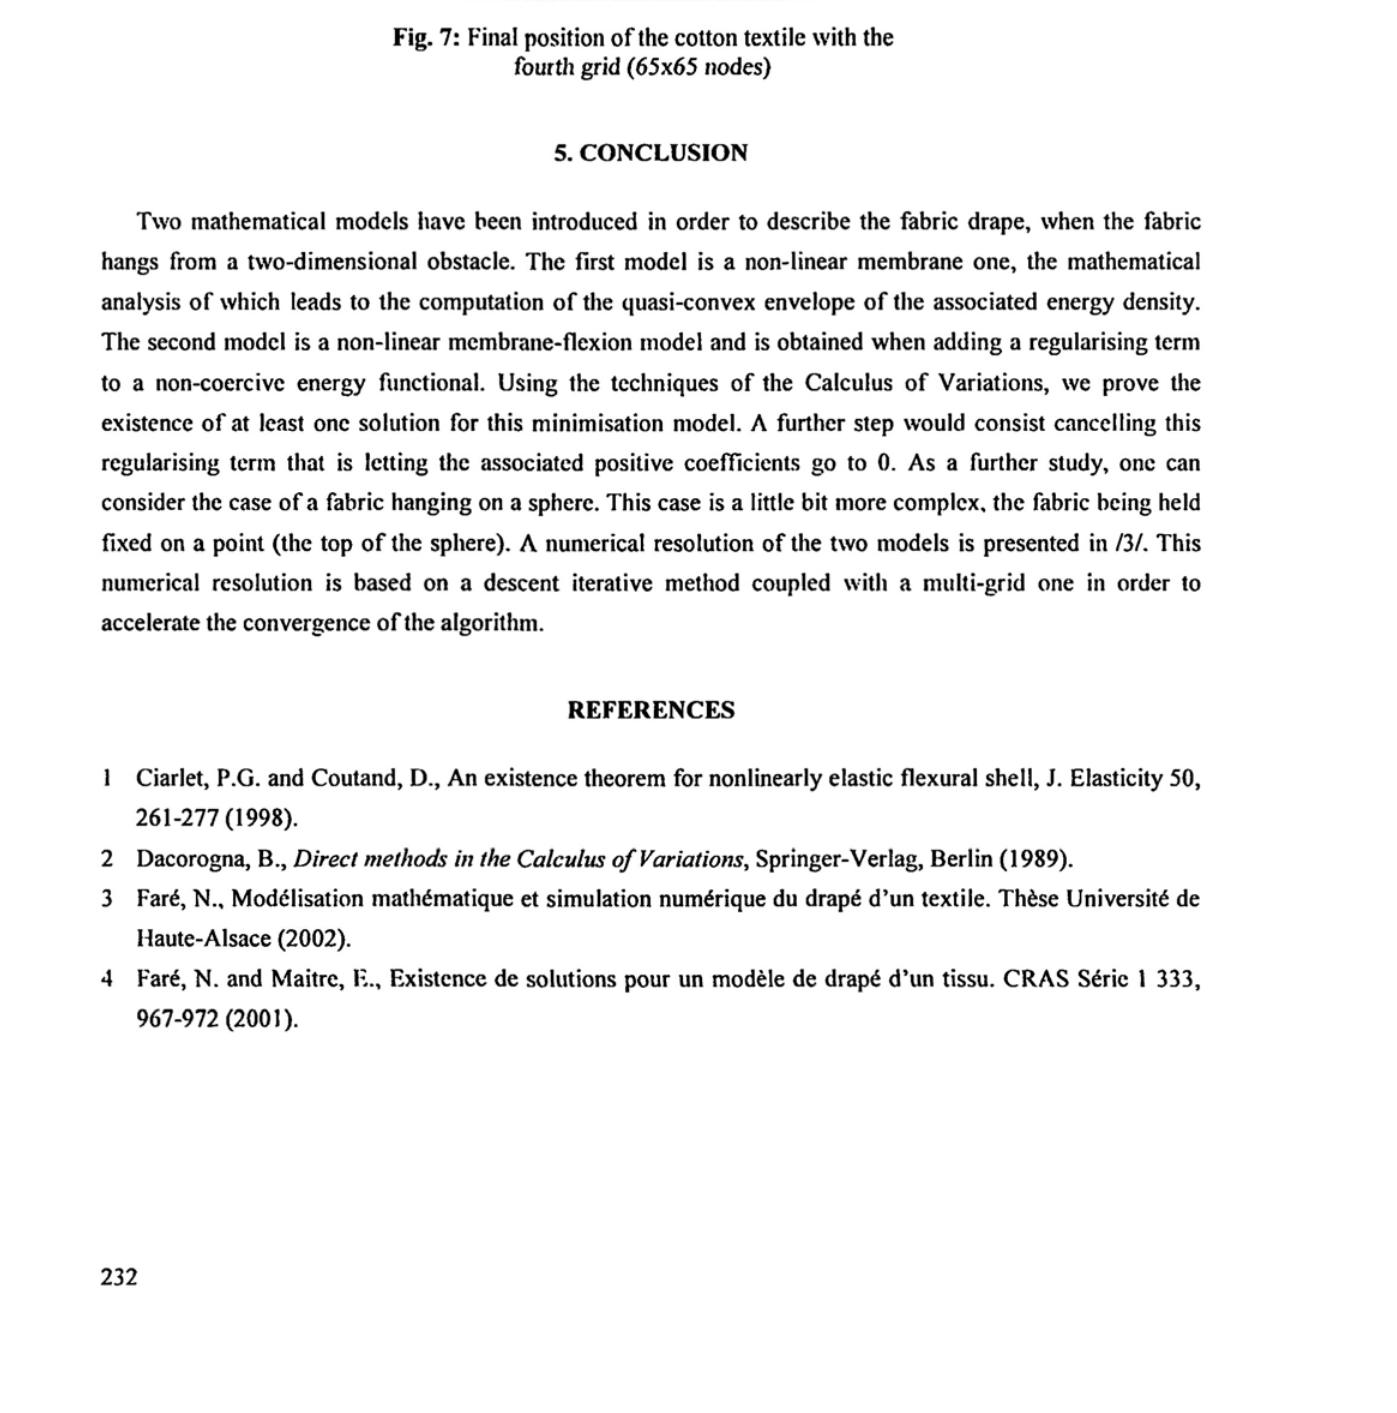
Fig. 7: Final position of the cotton textile with the fourth grid (65x65